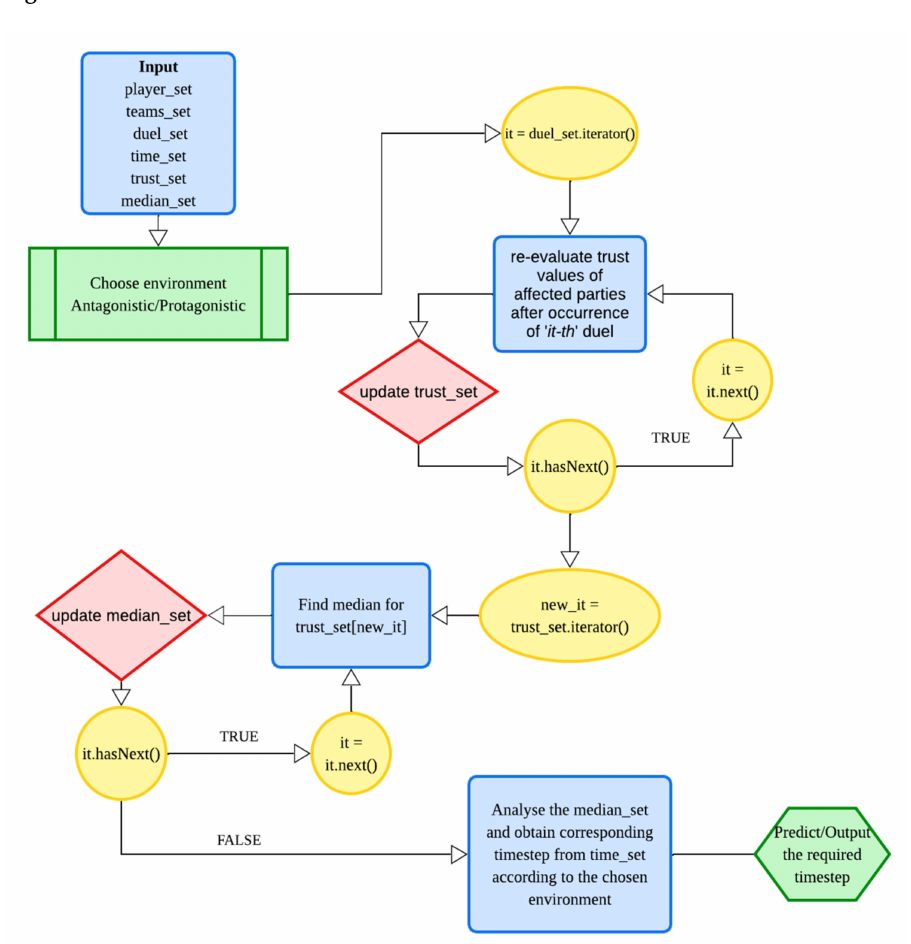
Figure 8. Flow of the main